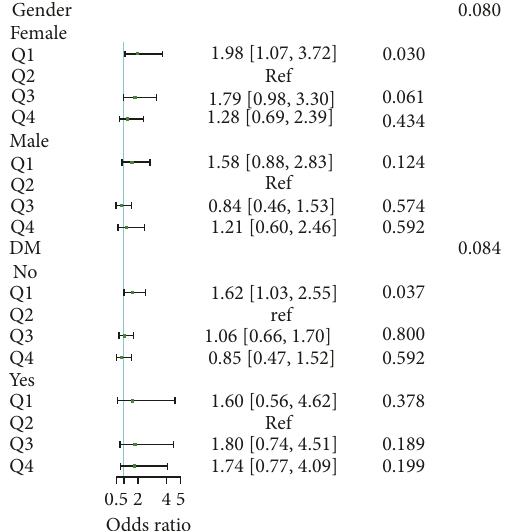
Figure 2: Subgroup analysis of the association between TyG quartile and 6-month readmission of HF